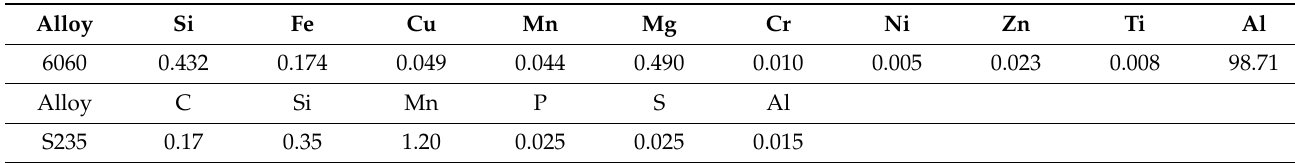
Table 1. Chemical composition of aluminium alloy 3.3206 (6060), and 1.0308 structural steel (S235) [26] (wt.%).